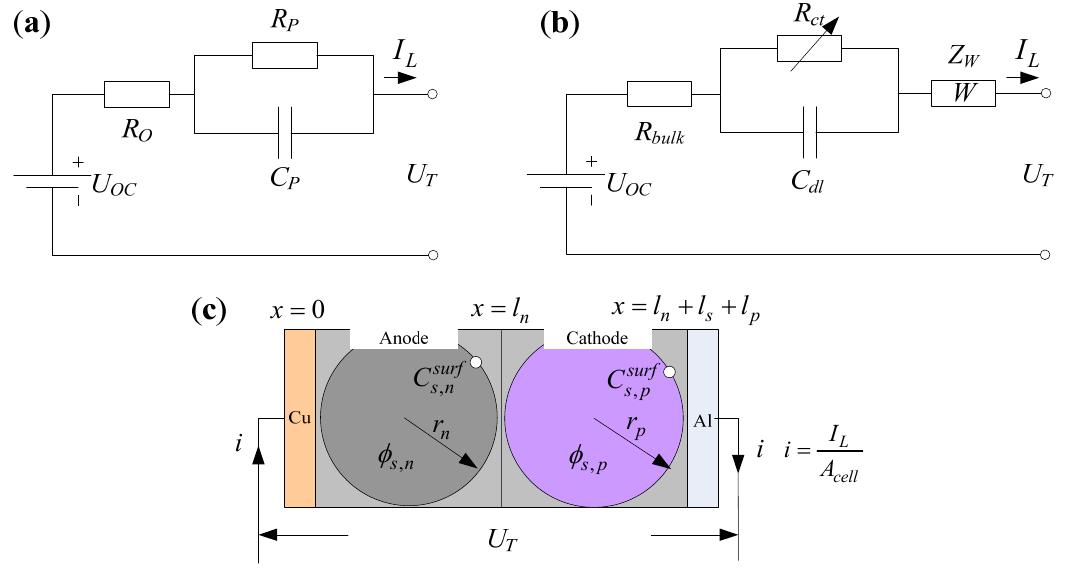
Figure 1. ( a ) First-order RC model; ( b ) a simple EIS model; ( c ) single particle